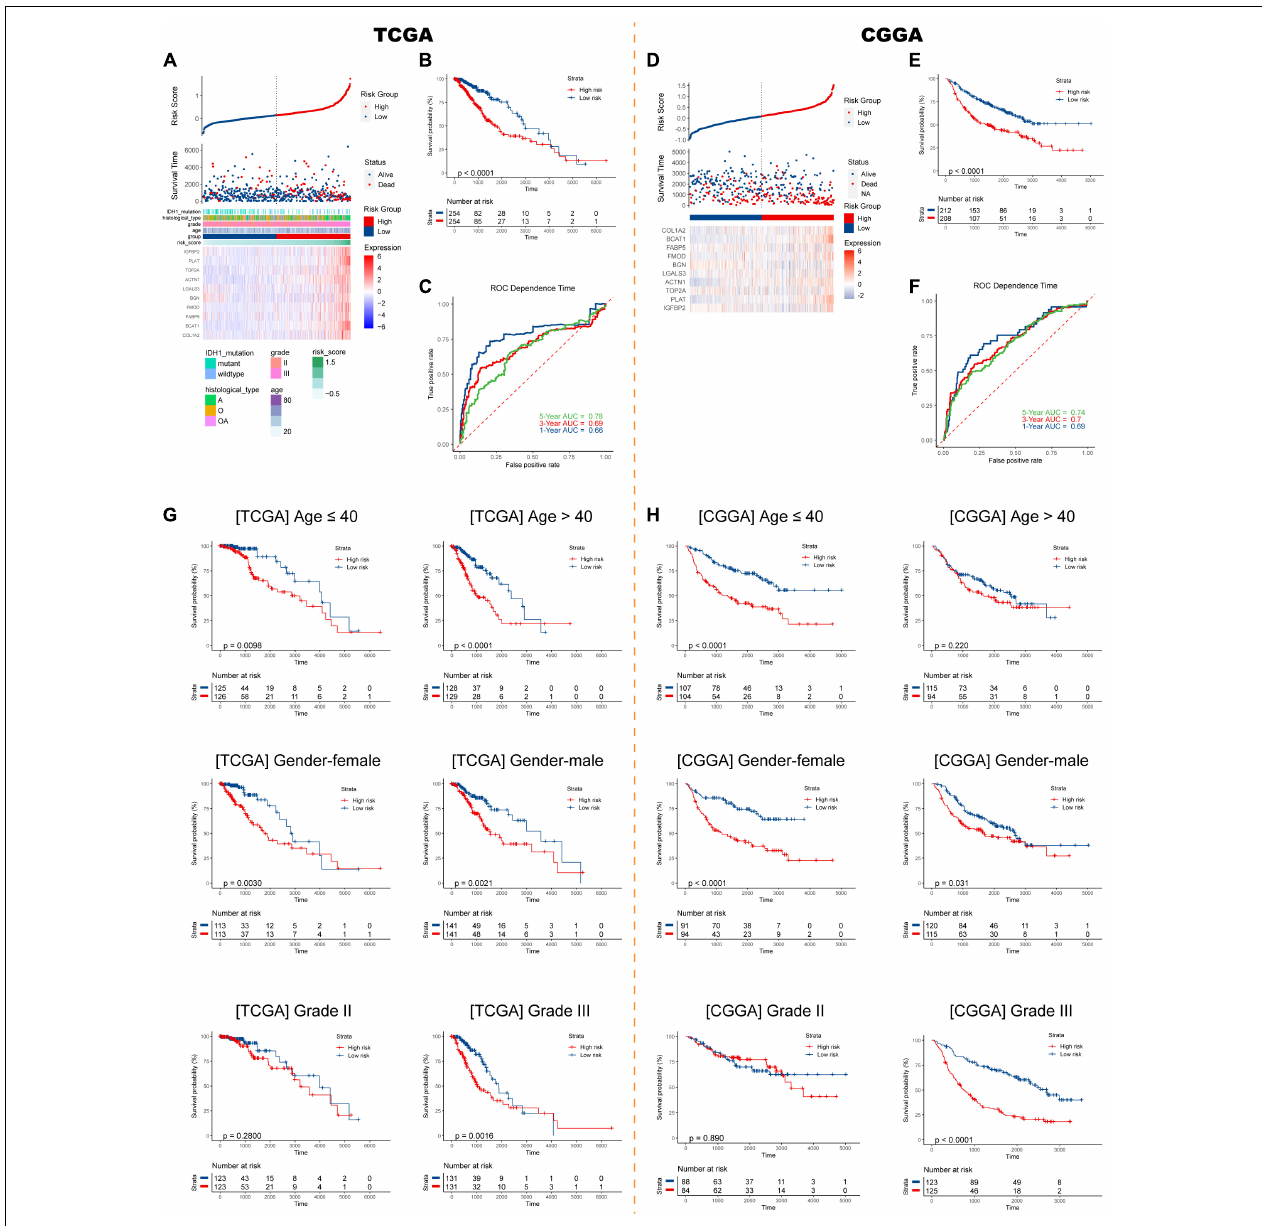
FIGURE 3 | Construction and validation of the IIRS. (A) Risk score, survival status, and expression pattern of model genes in each patient in the training cohort. (B) Kaplan–Meier analysis of patients in the high- and low-risk groups. (C) Time-dependent ROC analysis of the IIRS in predicting prognosis. (D–F) Validation of the IIRS in the CGGA cohort. (G,H) Kaplan–Meier analysis of patients in the high- and low-risk groups in stratified subgroups in the TCGA and CGGA